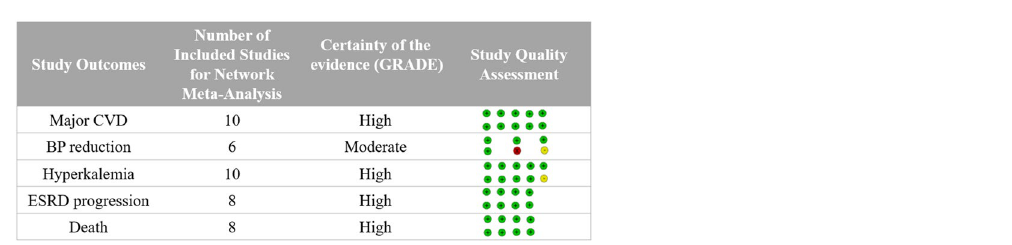
Figure 2. Network plot of included studies.